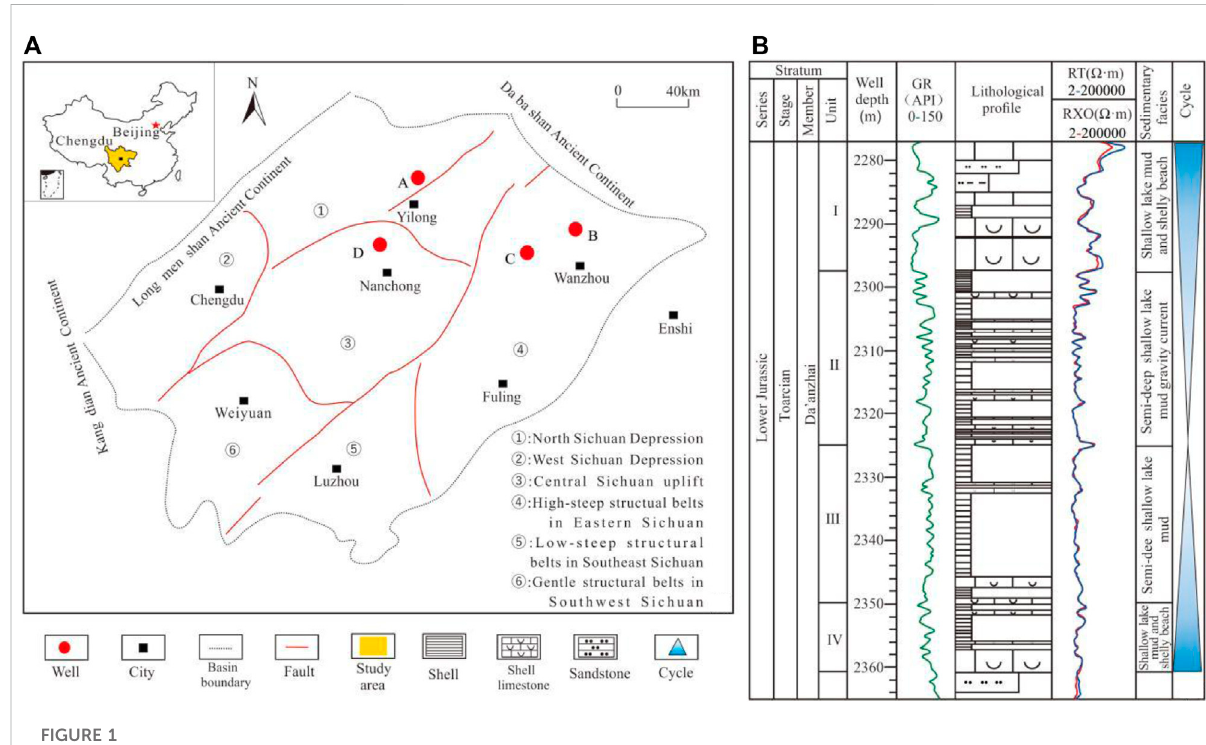
FIGURE 1 Structural location of the research area (A) and formation histogram of well C (B)